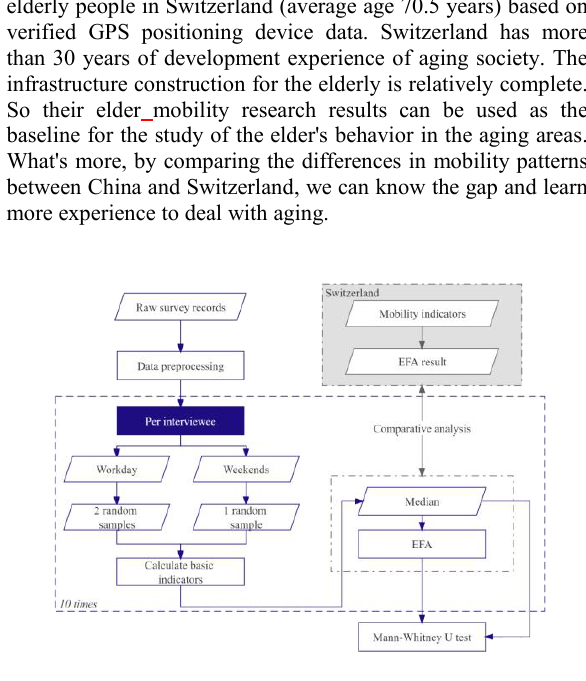
Figure 1 . The overall workflow of the study This study selects mobility indicators from Fillekes et al. (Fillekes et al. 2019c) conducted quantitative research on the mobility of the elderly in southeast China, and compared the results with the elderly in Switzerland.